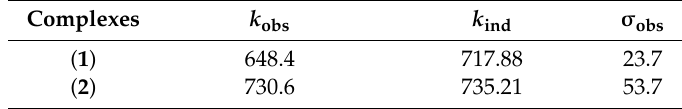
Table 2. Experimentally observed rate constants k obs , pH-independent k ind rate constants, and standard deviations.